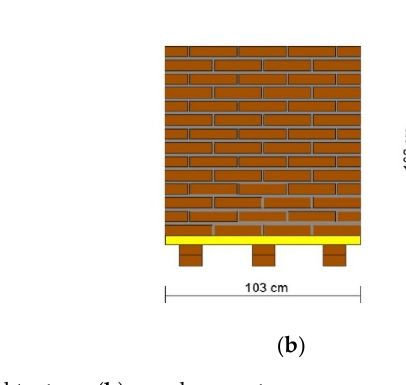
Figure 1. ( a ) Masonry panel texture, ( b ) panel geometry.